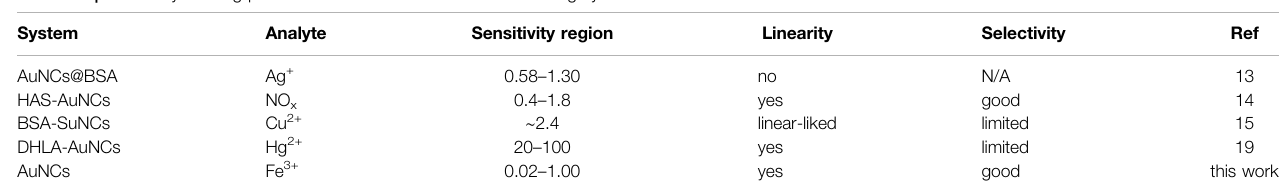
TABLE 3 | Some key sensing parameters of AuNCs and literature sensing systems.